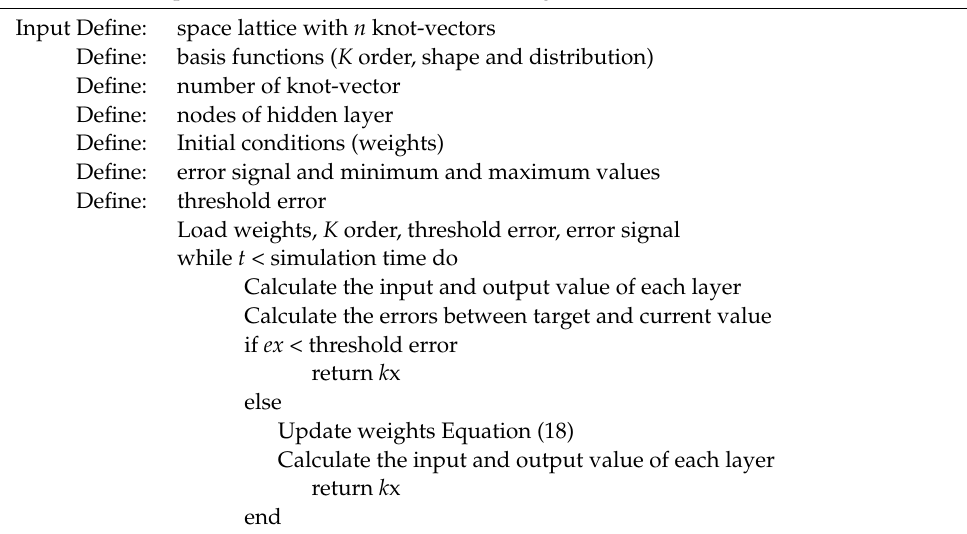
Algorithm 1 B-Spline Neural Network on-line training